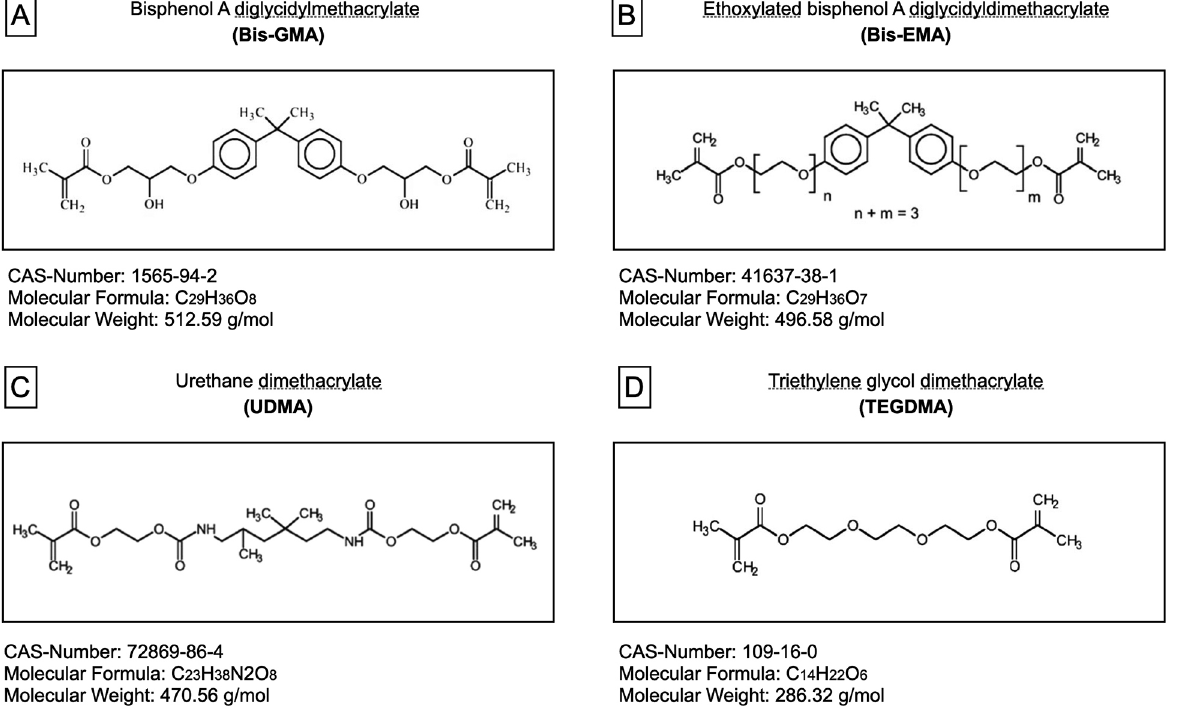
Figure 1- Chemical information of the monomers: (A) Bis-GMA; (B) Bis-EMA; (C) UDMA; (D) TEGDMA